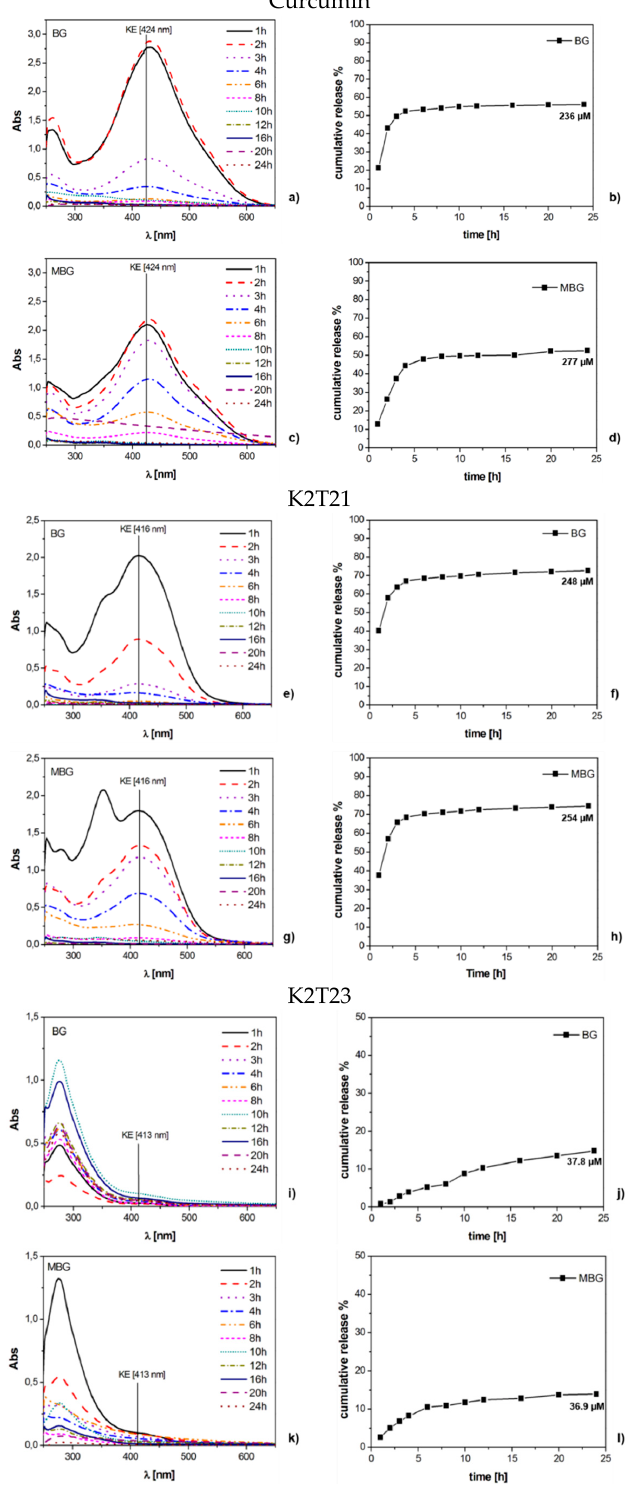
Figure 4. UV-Vis spectra and cumulative release in pure water (expressed in %) of BG and MBG samples loaded with: curcumin ( a – d ); K2T21 ( e – h ); and K2T23 ( i – l ).